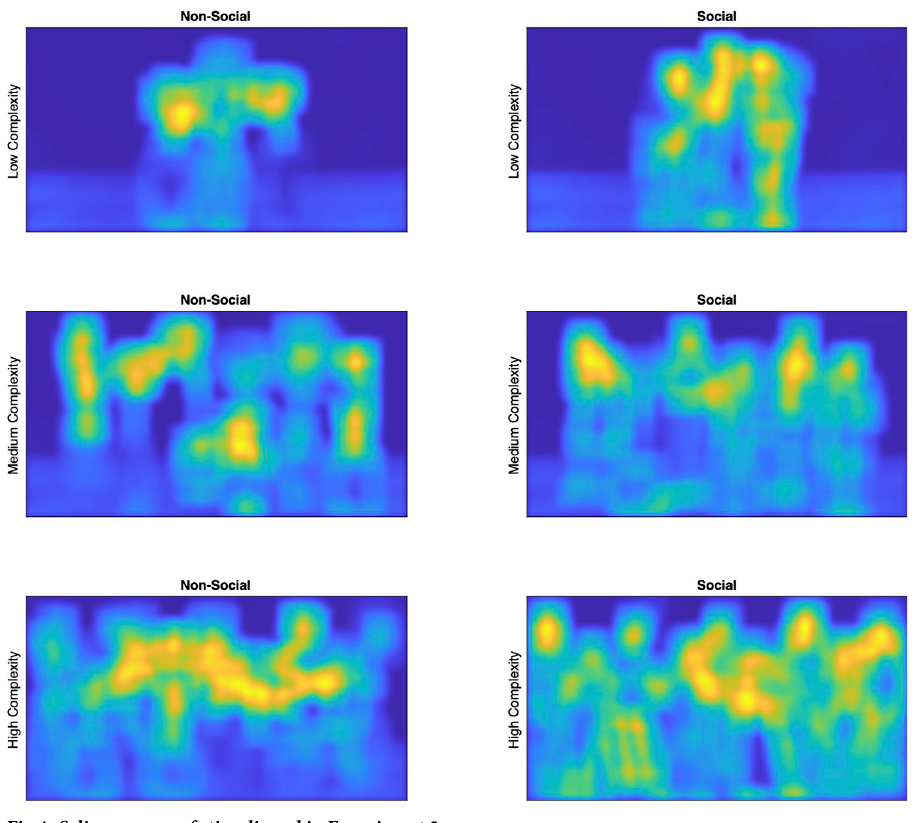
Fig 4. Salience maps of stimuli used in Experiment